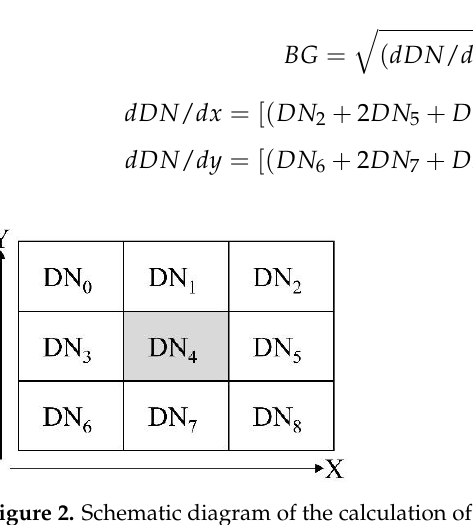
Figure 2. Schematic diagram of the calculation of the brightness gradient.